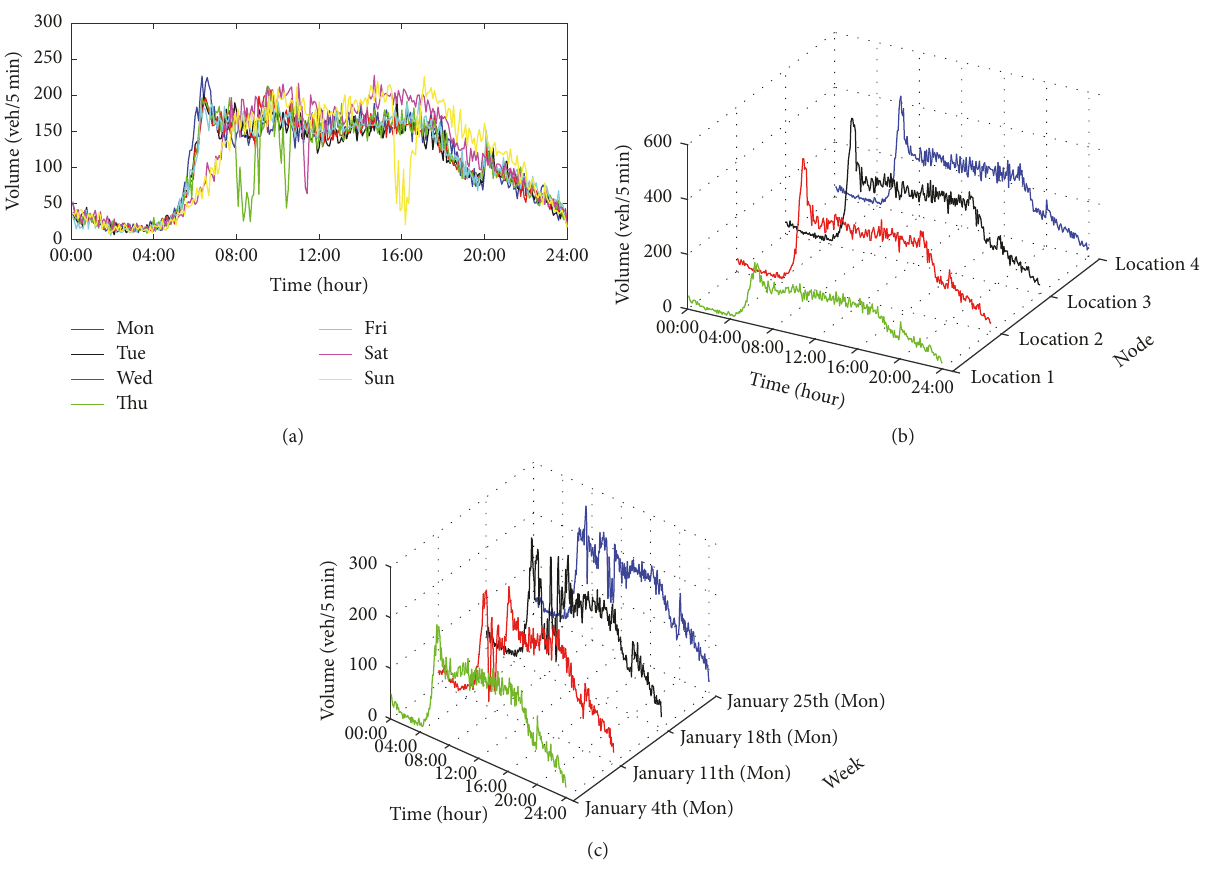
Figure 4: The trend of the various modes of traffic data. (a) Day mode and time mode. (b) Space mode. (c) Week mode.